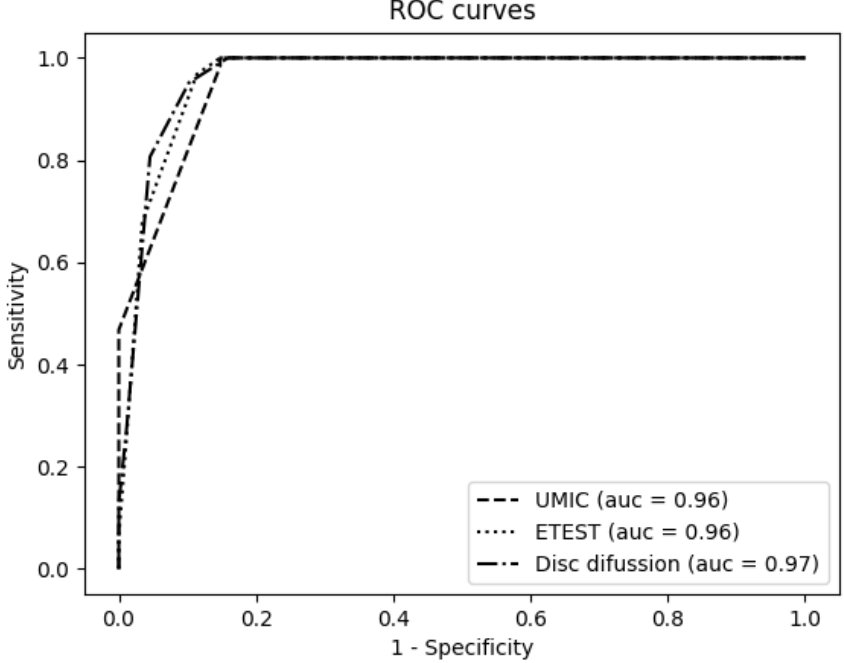
Figure 1. Receiver operating characteristic (ROC) curves for the Etest ® , UMIC ® and disc di ff usion using the broth microdilution method (BMD) as reference.